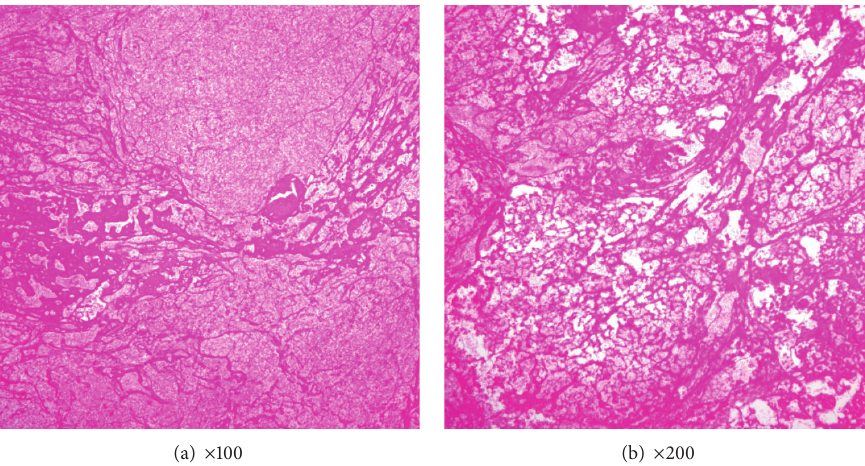
Figure 4: Histopathological findings (HE staining). Histopathological analysis revealed mostly necrotic muscle tissues, but neoplastic cells were not observed in the soft tissue resected from the lesion (a and